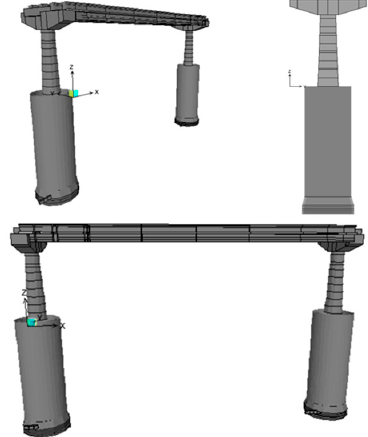
Figure 2. The SAP2000 model used in this study.